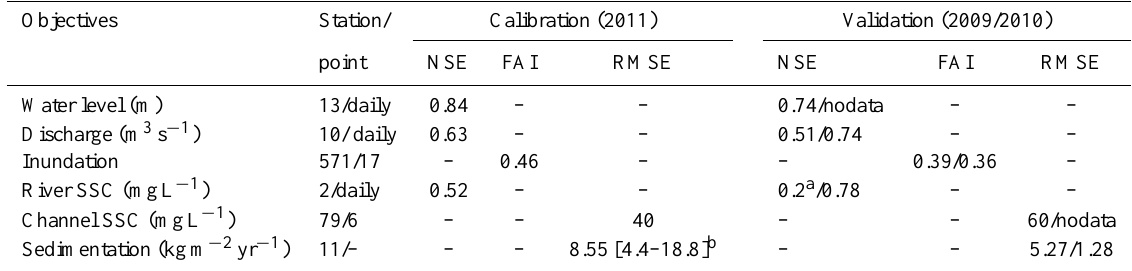
Table 2. Model performance: calibration, data (locations and number of points), results of calibration (year 2011) and of validation (years 2009 and 2010). The model performance measures are Nash–Sutcliffe efficiency (NSE), flood area index (FAI), root mean square error (RMSE).